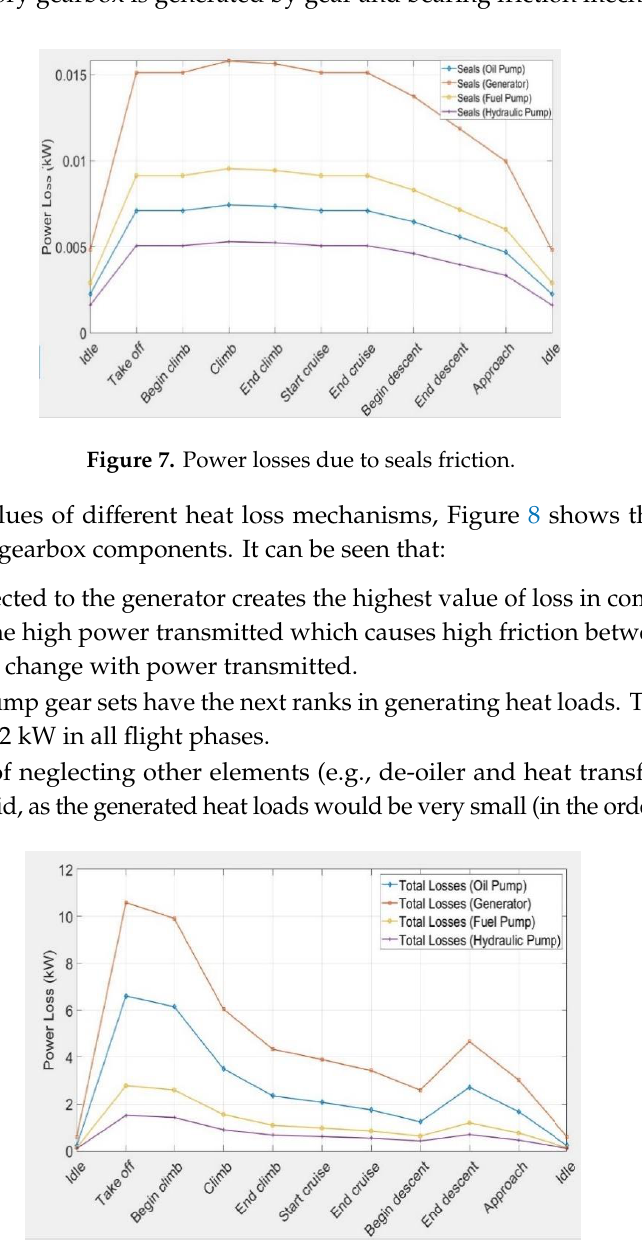
Figure 6. Power losses due to bearing churning.